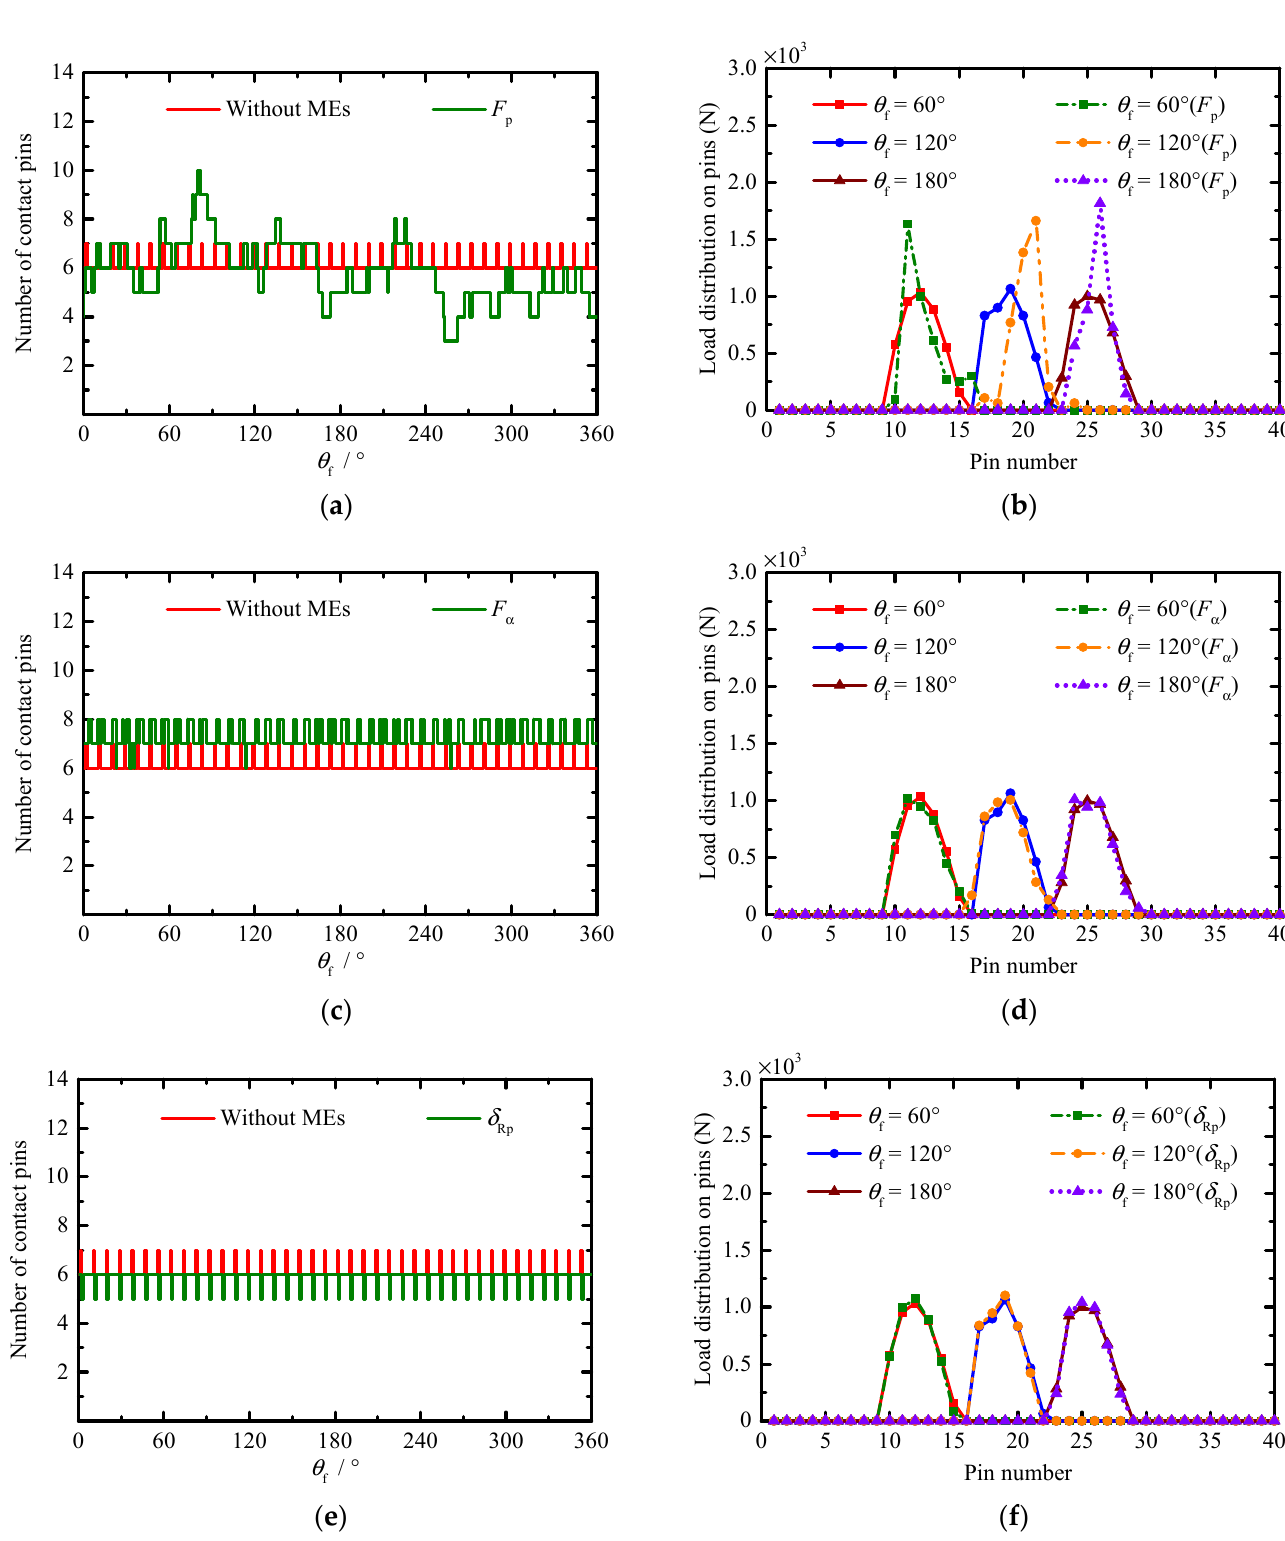
Figure 12. Number of contact pins and load distribution on pins with different types of MEs: ( a , b ) pitch deviation, ( c , d ) profile deviation, ( e , f ) pin center circle diameter deviation.